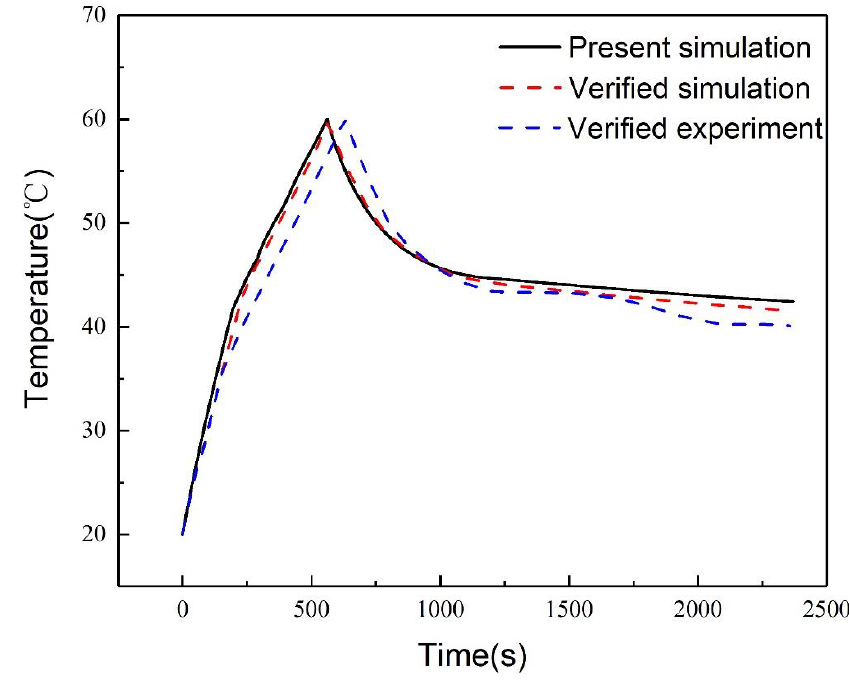
Figure 4. Validation of numerical scheme. (Data from Sun et al. [18]).